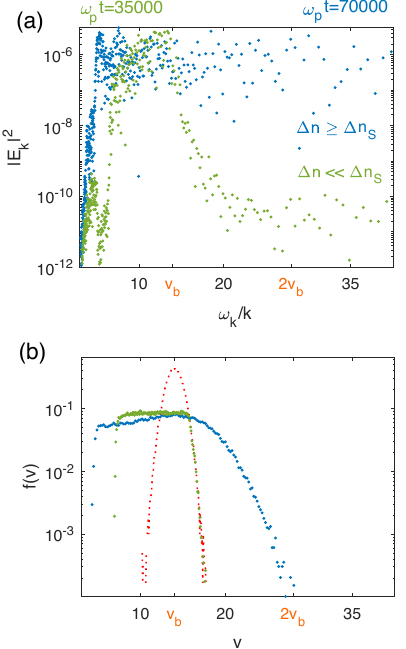
Figure 6. ( a ) Wave energy spectra | E k | 2 (in logarithmic scales) at asymptotic times, as a function of the phase velocities v = ω k / k (cid:38) 3 v T above the thermal range, for ∆ n (cid:39) 0.001 (cid:28) ∆ n s (green, at ω p t = 35,000) and ∆ n (cid:39) 0.04 > ∆ n s (blue, at ω p t = 70,000). ( b ) Corresponding electron velocity distributions f ( v ) (in logarithmic scales), superposed to the initial distribution (red), for ∆ n (cid:39) 0.001 at ω p t = 35,000 (green) and ∆ n (cid:39) 0.04 at ω p t = 70,000 (blue). Main parameters are the following: v b / v T = 14, ∆ v b / v b = 0.08, n b / n 0 (cid:39) 2.5 × 10 − 5 . All variables are